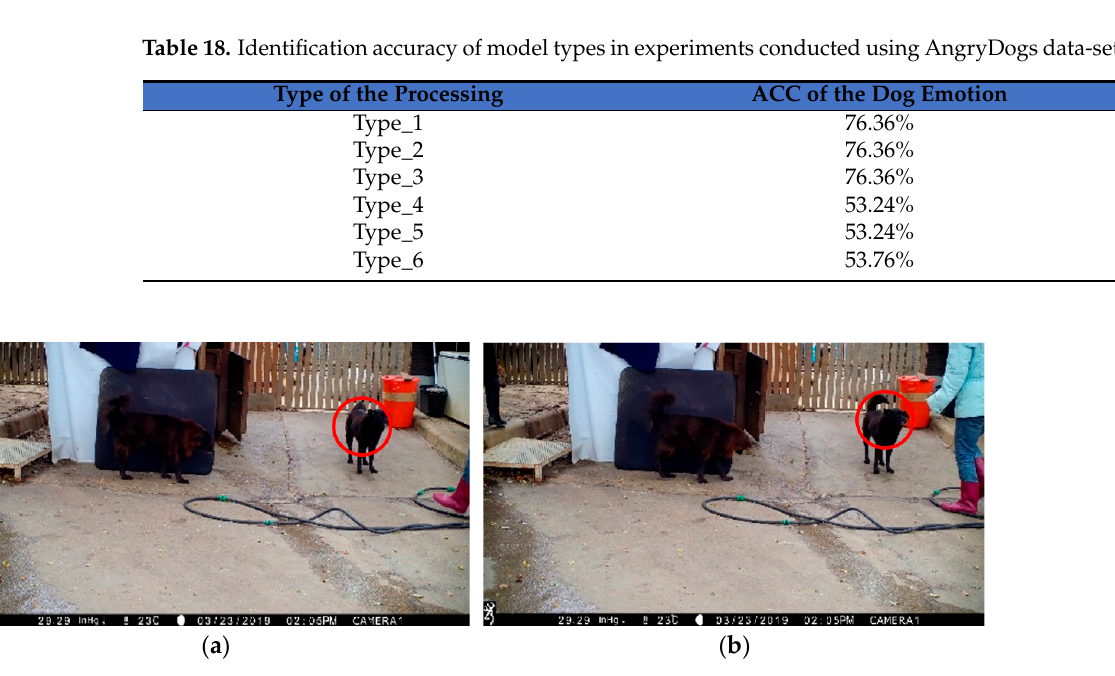
Figure 22. Dogs with similar emotions. ( a ) Neutral (or general); ( b ) Happy (or